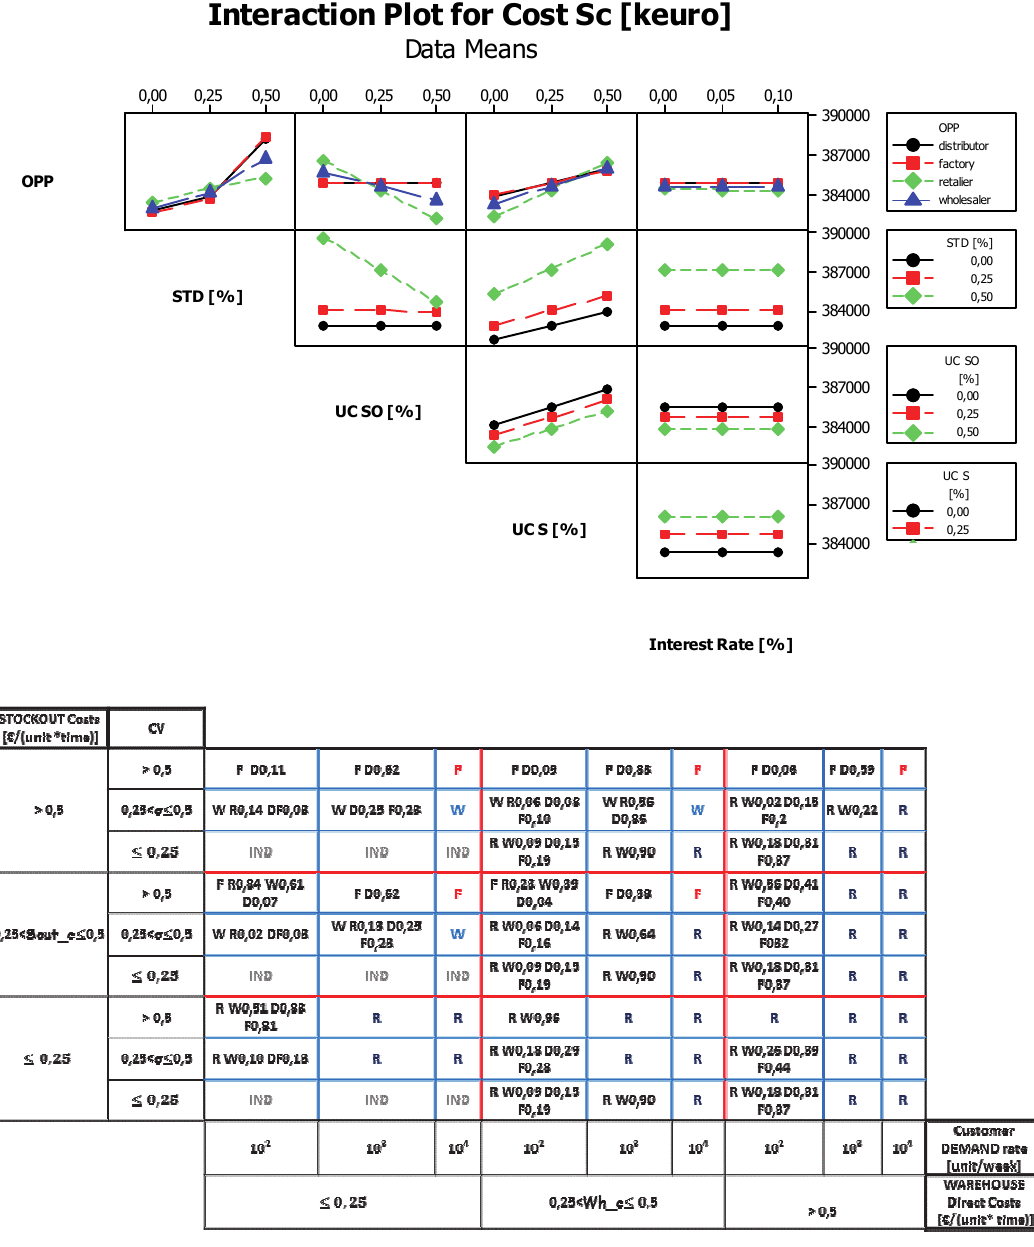
Fig. 11. Sensitiveness analysis under different simulation scenarios in four echelons of SCs with centralised control strategy : Annuity Stream (cost) and NPV reports are reported under different configuration